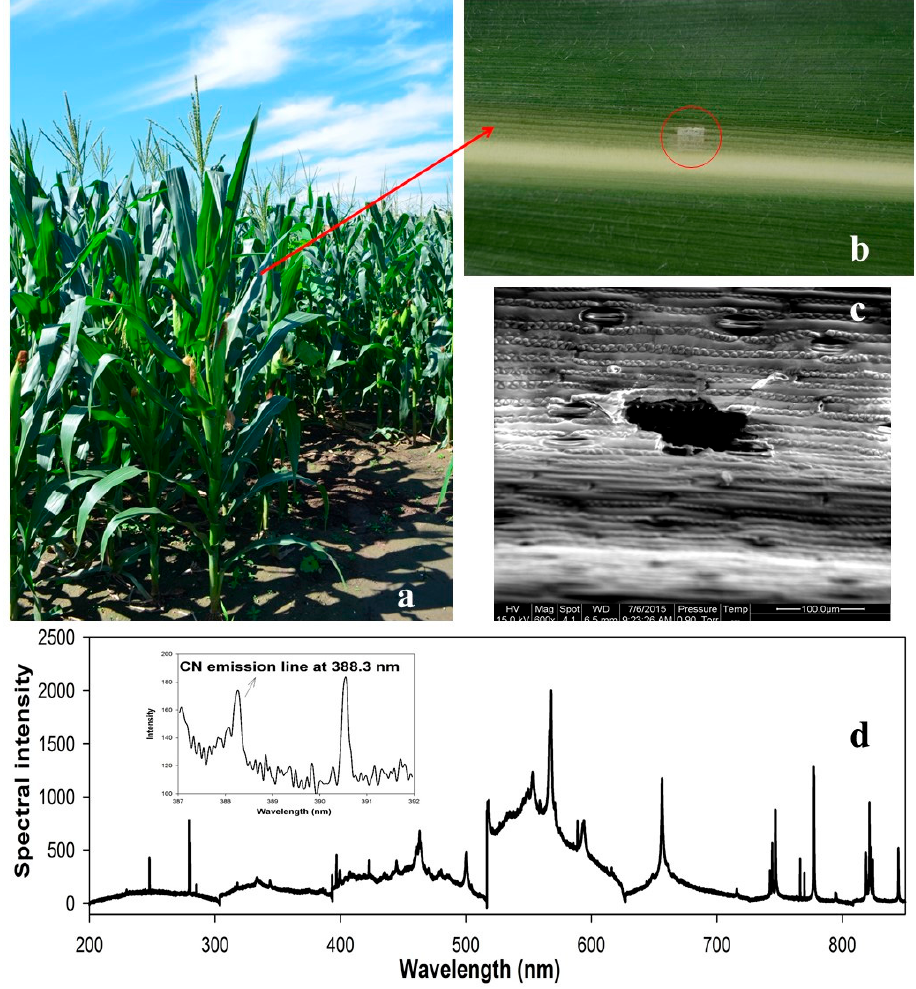
Figure 2. The photographs in a real application of LipsImag for an in-field measurement. ( a ) Maize plants for the elemental mapping experiment; ( b ) Photograph of a maize leaf after a 20 × 20 scanning by LipsImag; ( c ) The microstructure of a single shot on a maize leaf by LipsImag; ( d ) A plasma emission spectra from the scanning that is shown in ( b ).